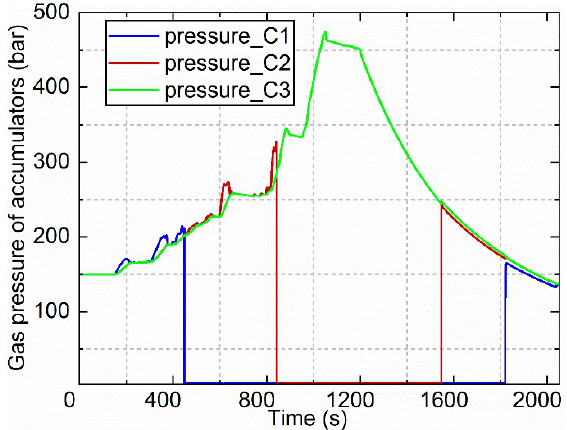
Figure 8. Gas pressure of different accumulators.